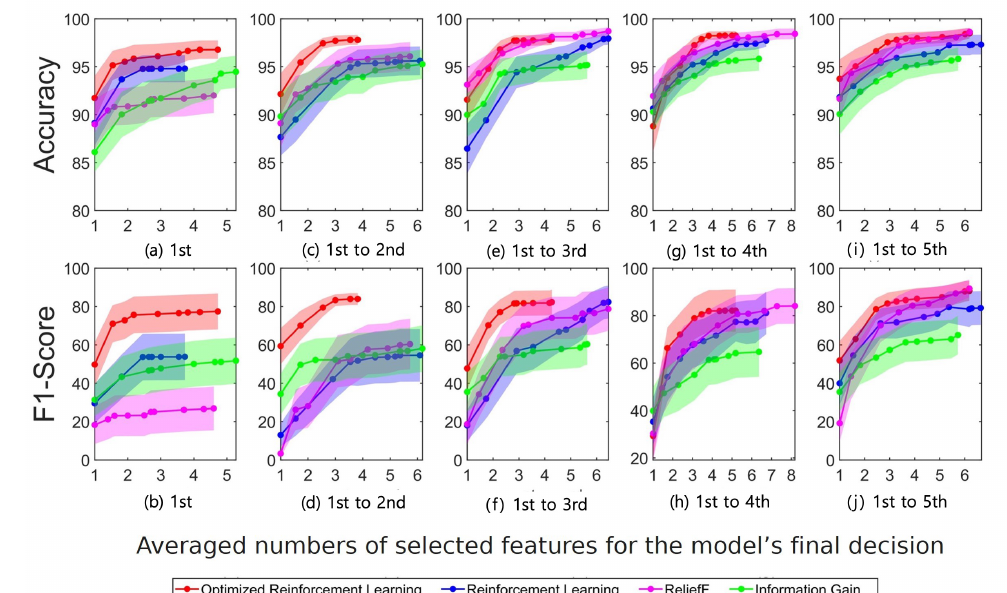
Figure 6. Random forest (RF) results using costly features. The accuracy and F1-score values across all subjects are illustrated with their variances in shades corresponding to the training days. Each training dataset includes the ECG signals recorded on the ( a , b ) 1st days, ( c , d ) 1st–2nd days, ( e , f ) 1st–3rd days, ( g , h ) 1st–4th days, and ( i , j ) 1st–5th